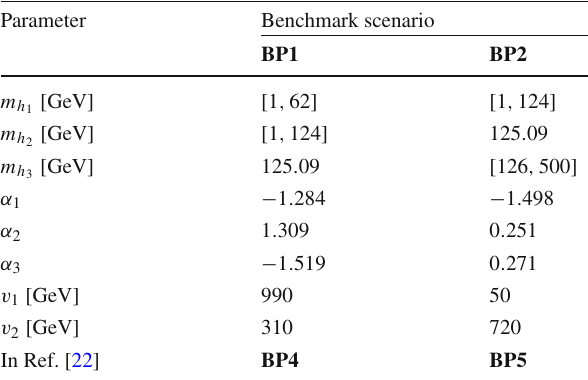
Table 1 Input parameter values for two benchmark scenarios